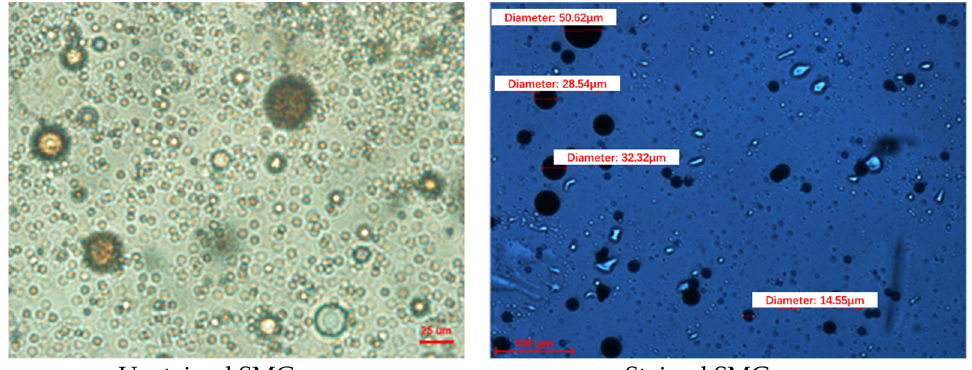
Figure 1. Micromorphology of SMG-mm − under microscope.